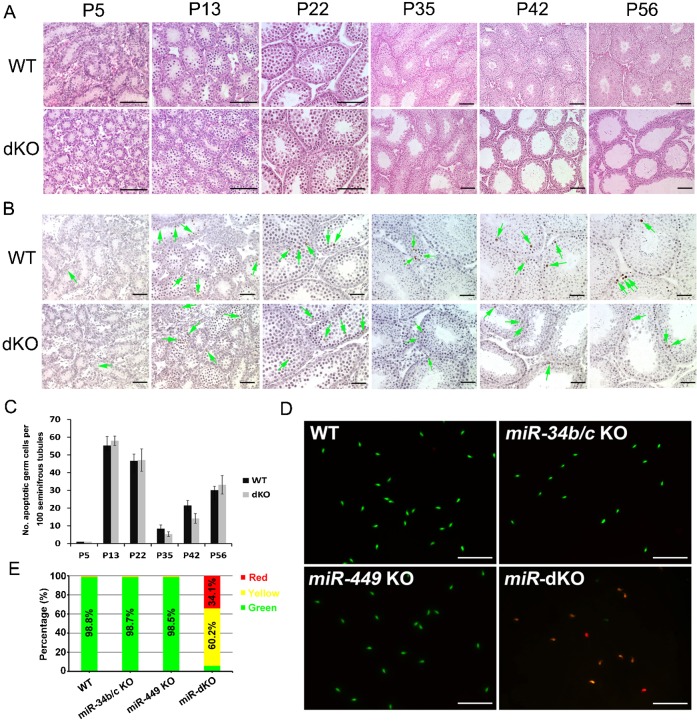
Histological and TUNEL analyses on developing testes of wild-type (WT) and miR-34b/c;miR-449 double KO (miR-dKO) male mice and the acridine orange (AO) staining of WT and miR-dKO spermatozoa.(A) Representative HE-stained paraffin sections of developing testes at postnatal 5 (P5), P13, P22, P35, P42 and P56 from WT and miR-dKO male mice. Scale bars = 100 µm. (B) Representative results of TUNEL assays on paraffin sections of WT and miR-dKO developing testes at postnatal 5 (P5), P13, P22, P35, P42 and P56. The apoptotic cells are stained in brown (green arrows). Scale bars = 50 µm. (C) Quantitative analyses of apoptotic germ cells in developing WT and miR-dKO testes at P5, P13, P22, P35, P42 and P56. X-axis shows the age and the y-axis represents the total number of TUNEL-positive germ cells per 100 seminiferous tubule cross sections. Data are presented as mean±SEM (n = 3). No significant differences were observed. (D) Representative immunofluorescent images showing the results of AO staining on epididymal spermatozoa collected from WT, miR-34b/c KO, miR-449 KO, and miR-dKO mice. Scale bars = 100 µm. (E) Quantitative analyses of AO staining results. Bars represent proportions of red, yellow/orange, or red sperm in WT, miR-34b/c KO, miR-449 KO, and miR-dKO mice.